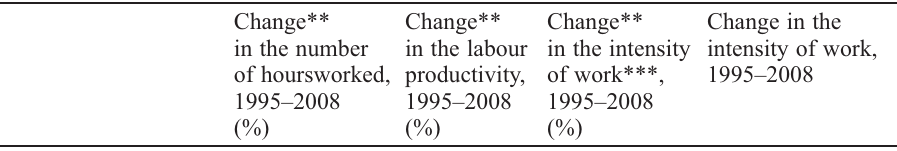
Table 1. Percentage change in the labour as factor of production use in Lithuanian industry during the period of